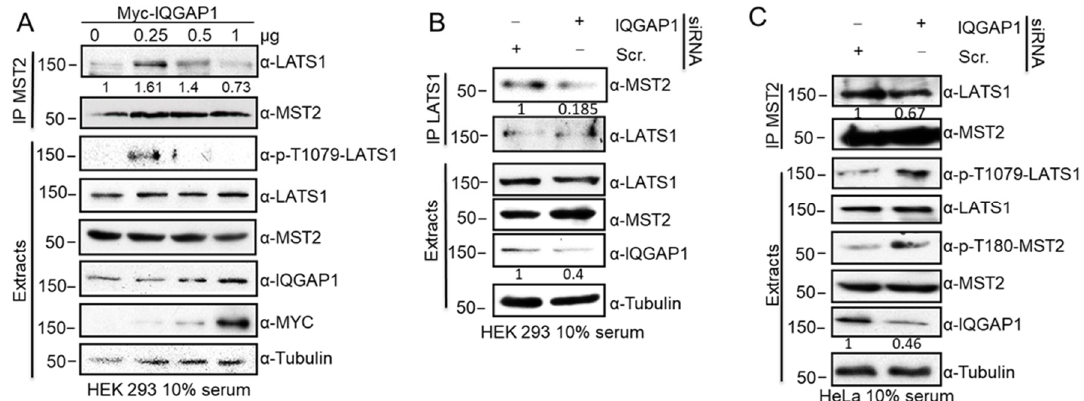
Figure 2. IQGAP1 scaffolds MST2-LATS1 interaction and regulates the activation of the kinases of the pathway. ( A ) HEK 293 cells were transfected with the indicated amounts of Myc-IQGAP1 constructs. Endogenous MST2 immunoprecipitates were analysed by western blot with the indicated antibodies. IP blots were quantified using ImageJ and the numbers show relative fold change of LATS1 normalised by MST2. ( B ) HEK 293 cells were transfected with IQGAP1 siRNA or a non-targeting (Scr.) siRNA pool. Endogenous MST2 and LATS1 immunoprecipitates were examined by western blotting. IQGAP1 and Tubulin blots were quantified using ImageJ and the numbers shows relative fold change of IQGAP1 normalised by Tubulin. IP blots were quantified using ImageJ and the numbers show relative fold change of MST2 normalised by LATS1. ( C ) HeLa cells were transfected with IQGAP1 siRNA or a non-targeting (Scr.) siRNA pool. Endogenous MST2 immunoprecipitates were examined by western blotting. Blots were quantified as in ( A ).